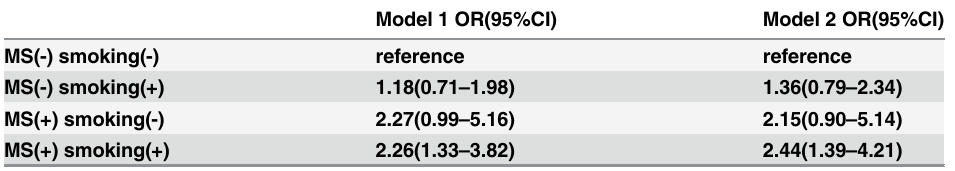
Table 6. Odds ratios for Coronary Artery Calcification according to Metabolic Syndrome and Smoking